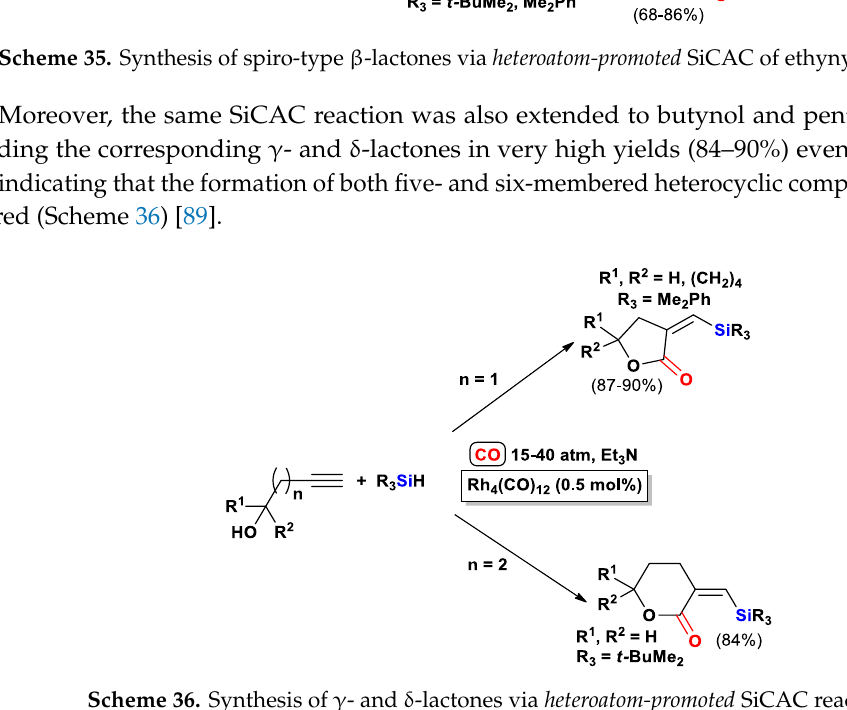
Figure 1. Rhodium-acyl intermediate hypothesized by Matsuda and co-workers in the heteroatom-promoted SiCAC of propargyl alcohols.